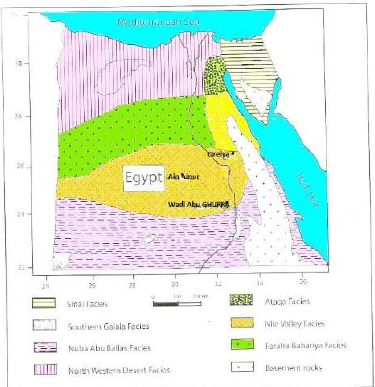
Figure 4: Geographic locations of the three Egyptian outcrops in central and southern Egypt in the Nile Valley Facies: Qreiya section, northeast Qena, Nile Valley, and North Ain Amur section, Kharga Oasis at Central Egypt, and Wadi Abu Ghurra section, West Aswan at South Egypt (Issawi et